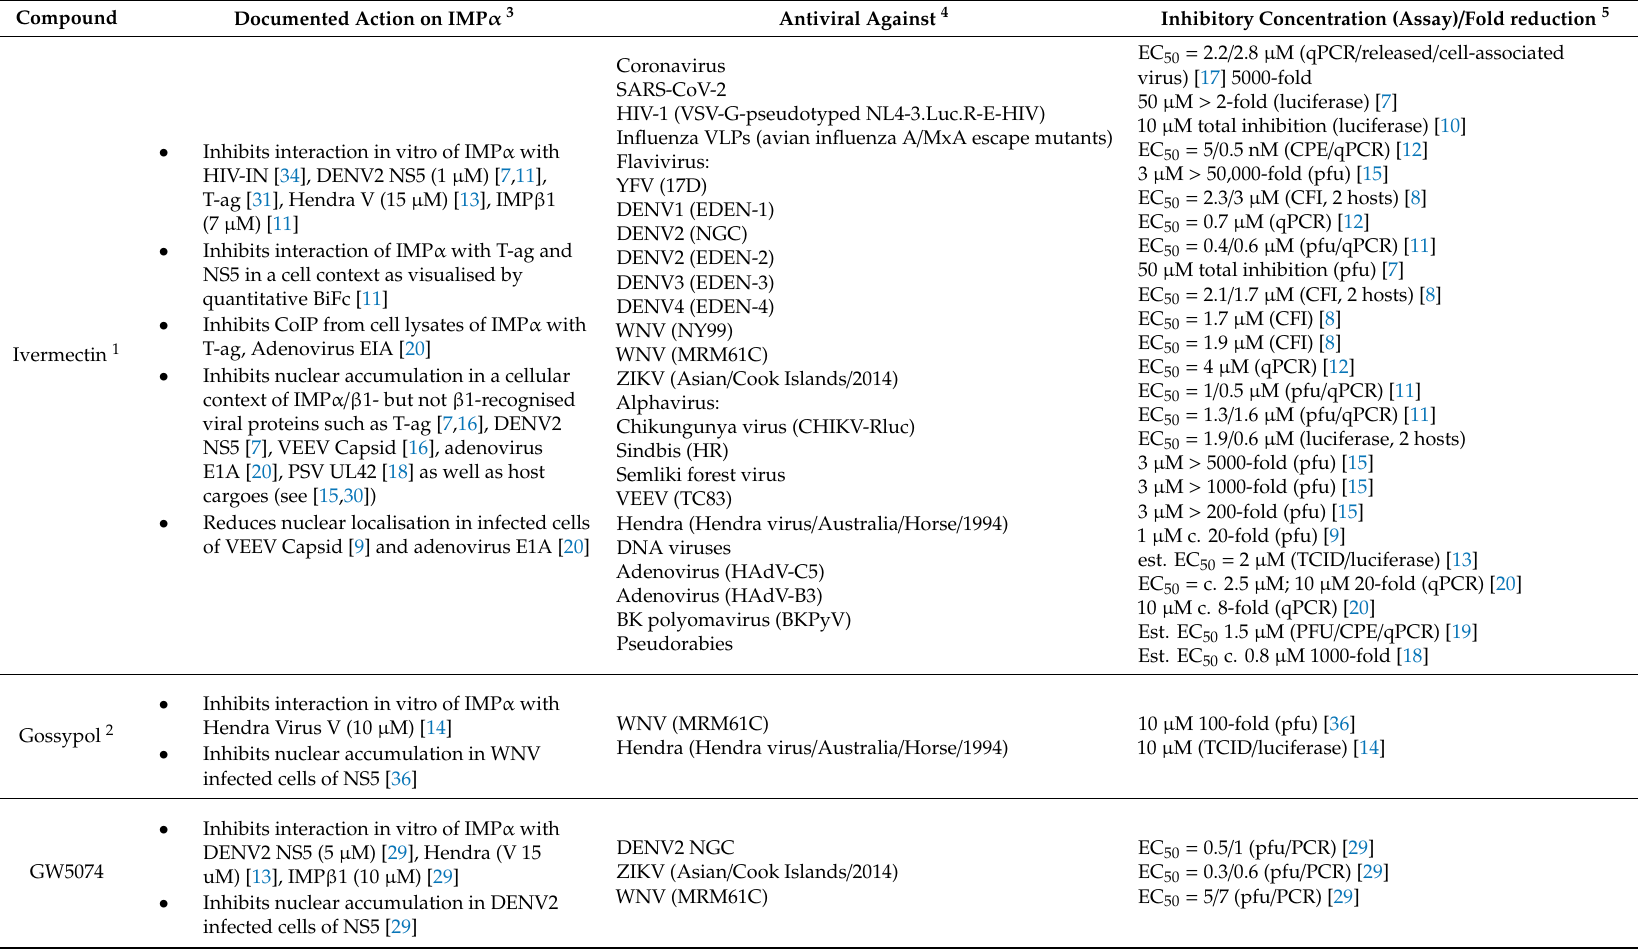
Table 1. In vitro properties of IMP α inhibitors with antiviral e ff